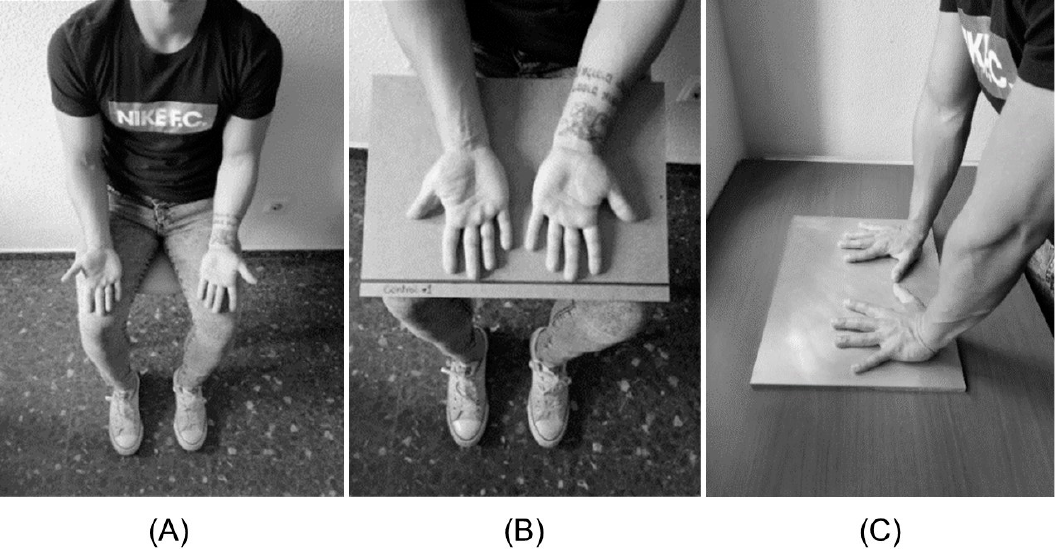
Figure 1. Different positions employed during the study. ( A ) Position to adapt the hands to environmental conditions. ( B ) Hand position during infrared imaging. ( C ) Cold stress test on a metal/aluminum plate.